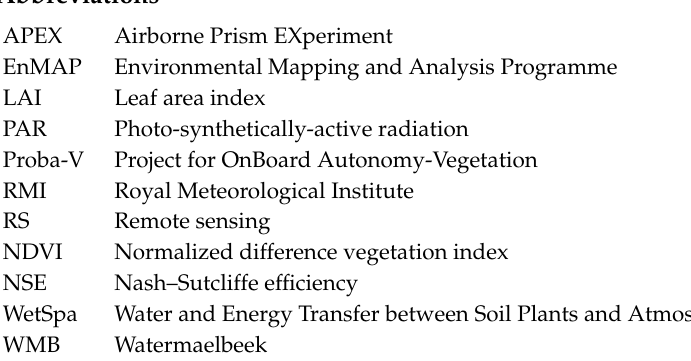
Table S1: Calibrated WetSpa parameters; Table S2: User input file for WetSpa; Table S3: List of Proba-V images. Acknowledgments: This research is co-funded within the framework of the UrbanEARS project SR/00/307 from the Belgian Federal Science Policy Office, Support to the Exploitation and Research in Earth Observation III (BELSPO STEREOIII), and the Belgian airborne calibration and validation sites for urban and forest (BELAIR-SONIA) project SR/03/333. The meteorological dataset is provided by the Royal Meteorological Institute (Uccle) and Flowbru (depot communal). We also want to thank Jeroen Degerickx for his contribution to the ground-truthing activities and Frederik Priem who provided the land cover map. English language editing was done by Steven Eisenreich. We further acknowledge the constructive feedback of the 3 reviewers and the efficient